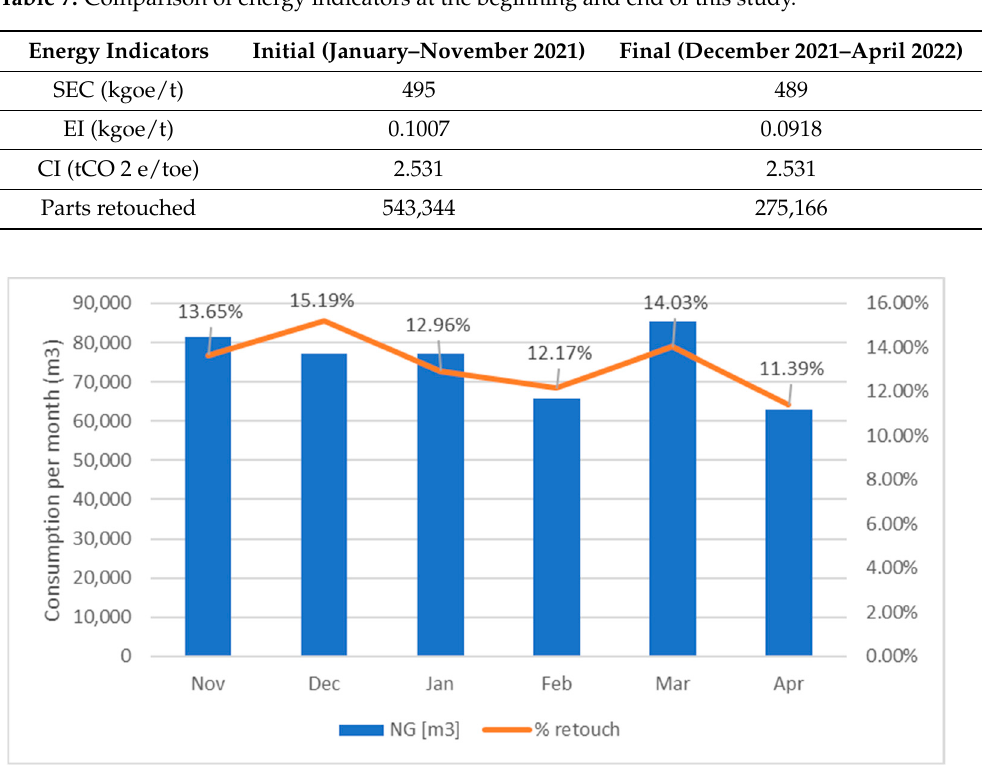
Figure 6. NG consumption and the comparison with the retouching percentage.